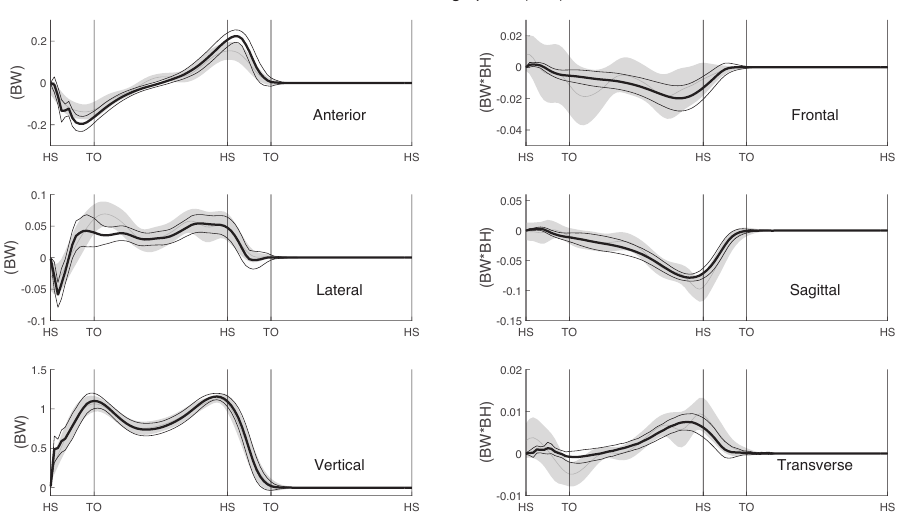
Figure 6. Ground reaction forces and moments (GRF&M) estimated using IMC (mean (thin grey line) ± 1 SD around mean (shaded area)), compared with measured FP data (mean (thick black line) ( ± 1 SD (thin black lines)) during normal walking. Curve magnitudes are normalized to body weight and body weight times body height for the GRF and GRM, respectively. Averaged over right and left steps of all 11 subjects.